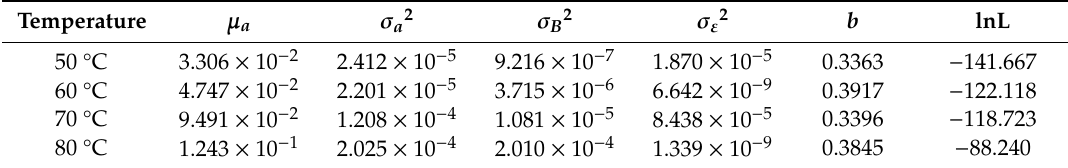
Table 7. Degradation parameters of O-type rubber sealing rings under each accelerated temperature stress.